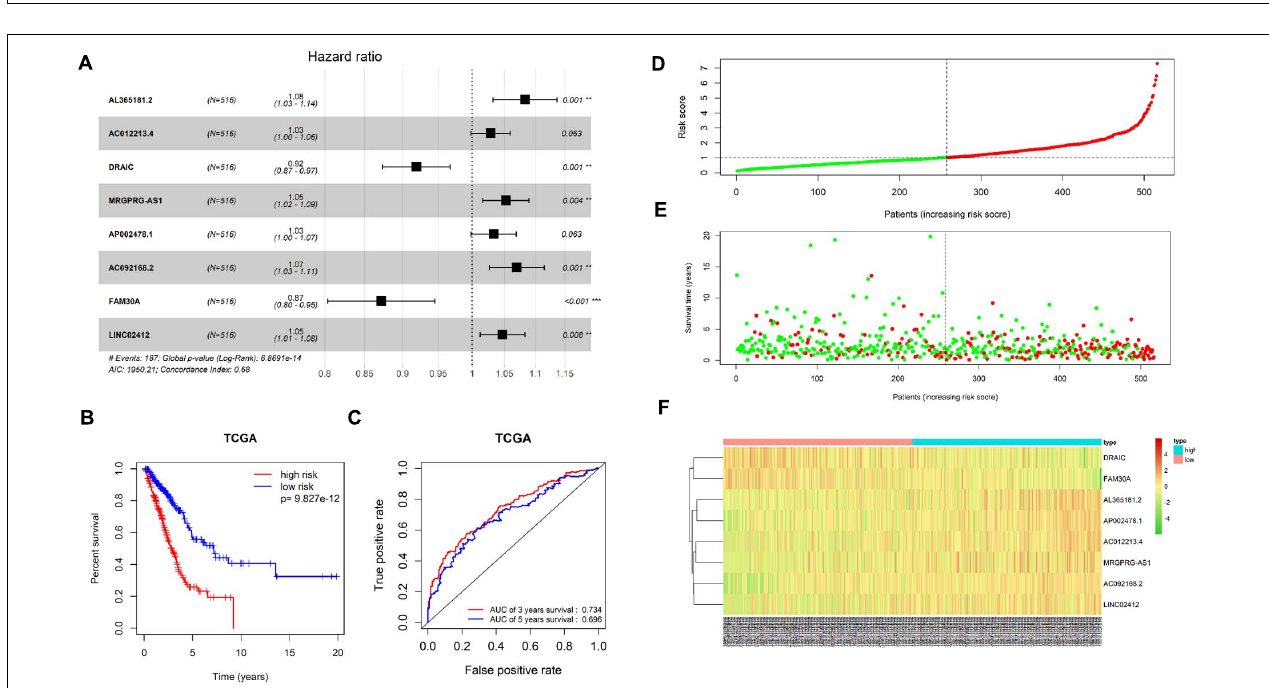
FIGURE 5 | Construction and validation of the eight-immune-related-lncRNA prognostic signature. (A) Screening and construction of an eight-immune-related-lncRNA prognostic signature by multivariate COX regression analysis. Forest plot shows hazard ratio (HR) and p -value of each lncRNA in the model. ** represents p < 0.01, *** represents p < 0.001. (B) Survival curves obtained by Kaplan–Meier survival analysis in high-risk and low-risk groups divided by the median risk score. (C) ROC curves and corresponding AUCs of 3-year survival and 5-year survival predicted by the prognostic model. (D) Distribution diagram of risk score of LUAD patients in TCGA-LUAD. The horizontal dotted line indicates the median risk score of all patients. (E) Distribution diagram of survival status of LUAD patients. Patient’s risk score is presented from low to high by left to right. The vertical dotted line represents the patients with a median risk score. Green dots represent survival and red dots represent death. (F) Heatmap of the expression of eight immune-related lncRNAs in cancer tissue of LUAD patients in high- and low-risk groups.